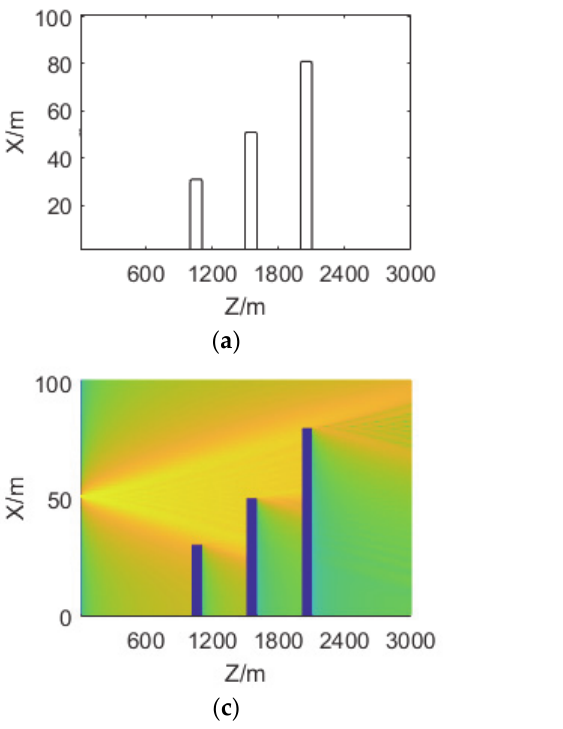
Figure 3. Forward field distributions in dB on different x ‐ z planes. ( a ) shows the locations of the three buildings. ( b – d ) are field distributions of y = 100 m, 120 m, and 140 m, respectively. It should be pointed out that the farther away from the plane where the radar is, the weaker the shelter effect of the building gradually becomes.